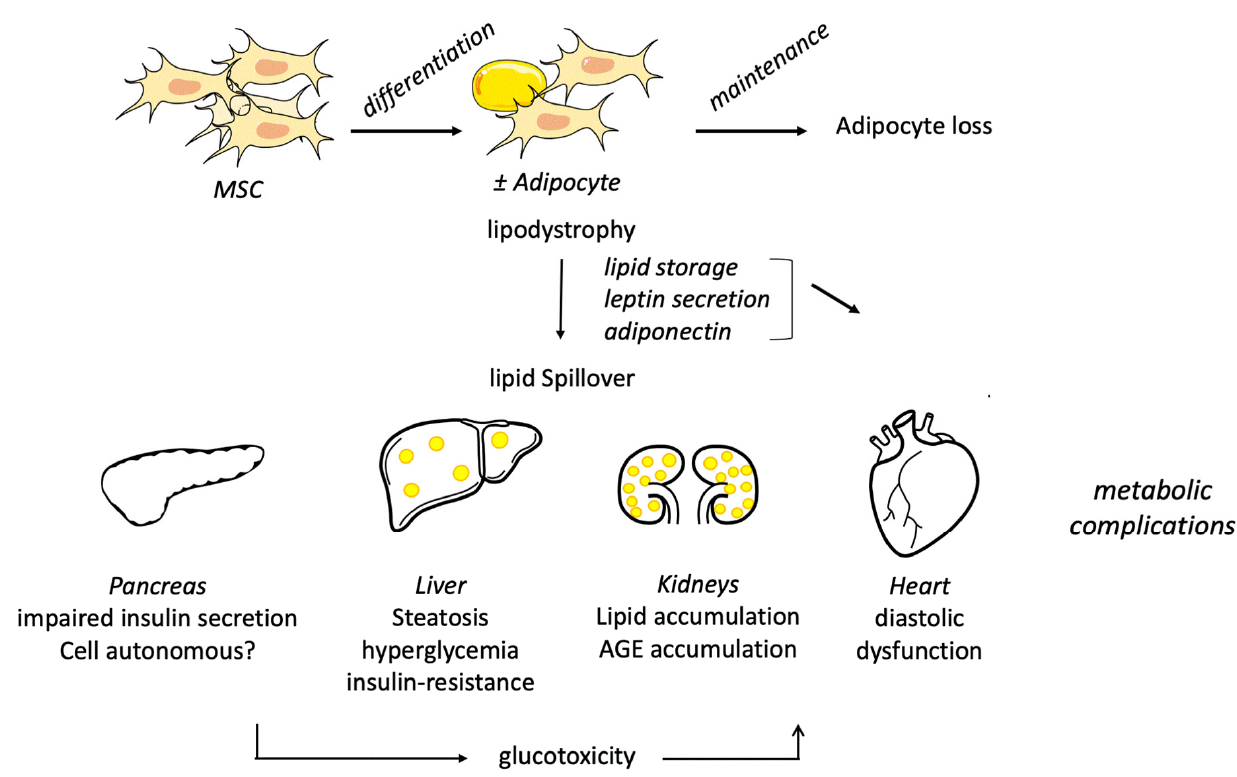
Figure 2. Physiopathology in seipin-deficient mice. Seipin deficiency leads to severe lipodystrophy that is the consequence of both adipogenesis impairment and alteration in mature adipocytes